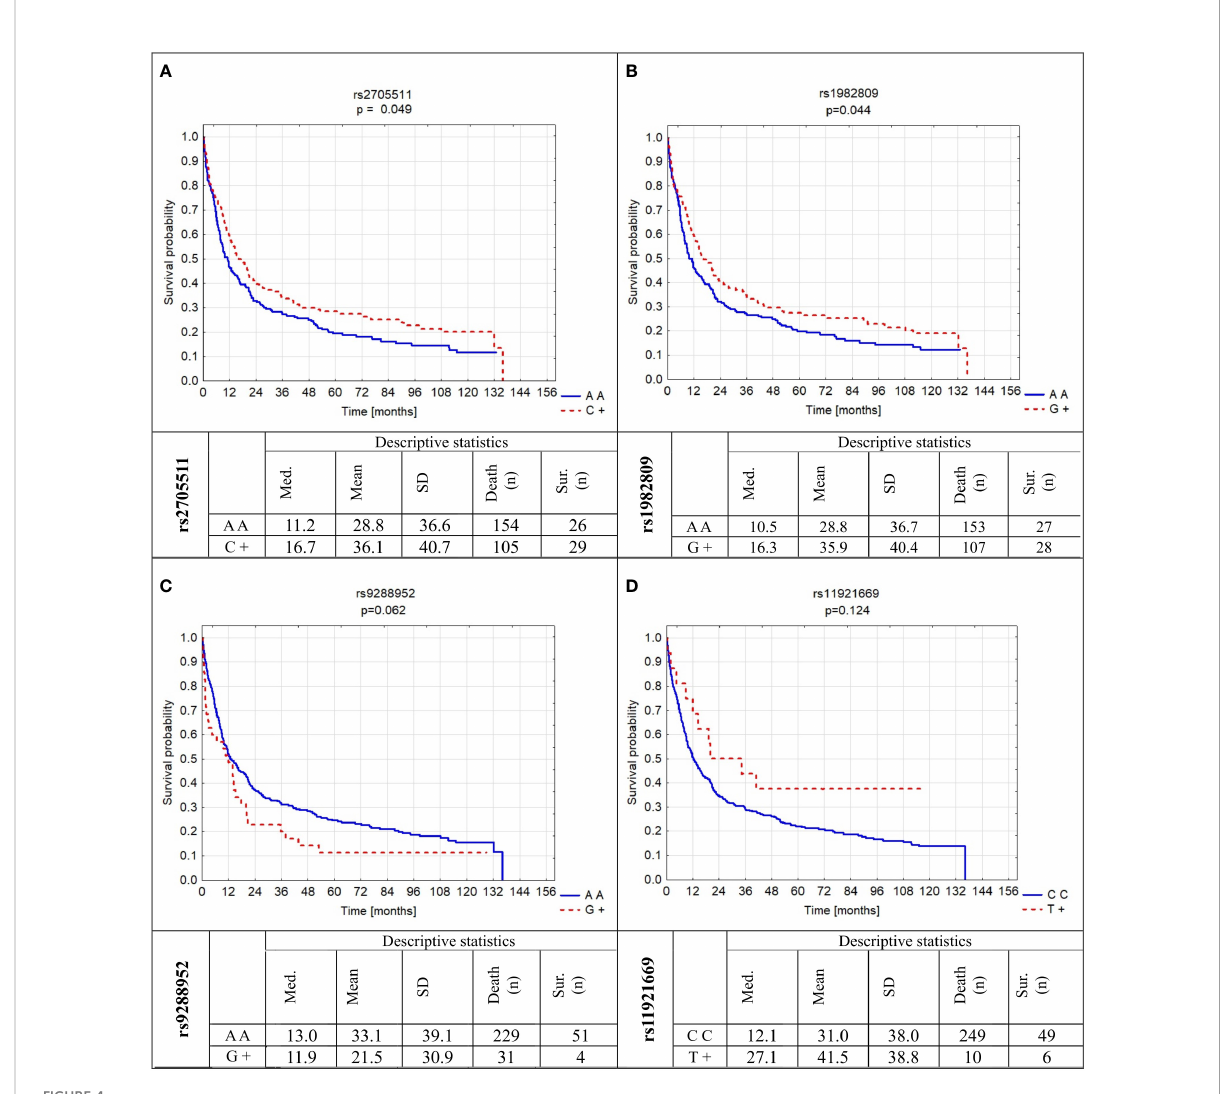
FIGURE 4 Probability of survival in relation to BTLA gene polymorphisms: (A) rs2705511; (B) rs1982809; (C) rs9288952; (D) rs11921669. Med., median; SD, standard deviation; sur., survival; n, number of